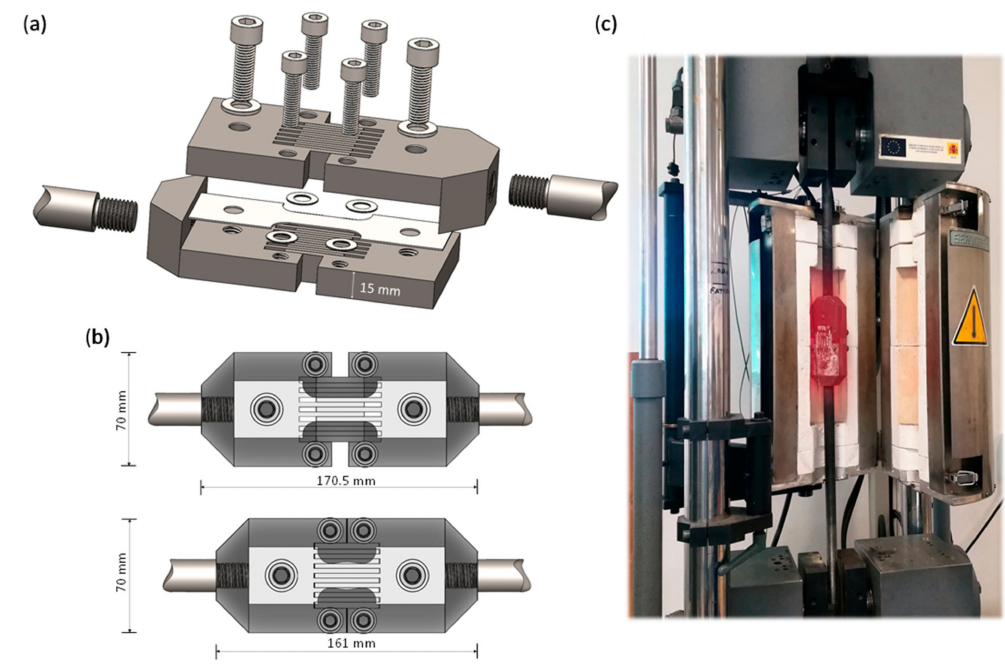
Figure 3. ( a ) Schematic of the assembly for compression tests [30]. ( b ) Initial and final (maximum achievable compression) stages of operation. ( c ) Compression device after a test at 750 ◦